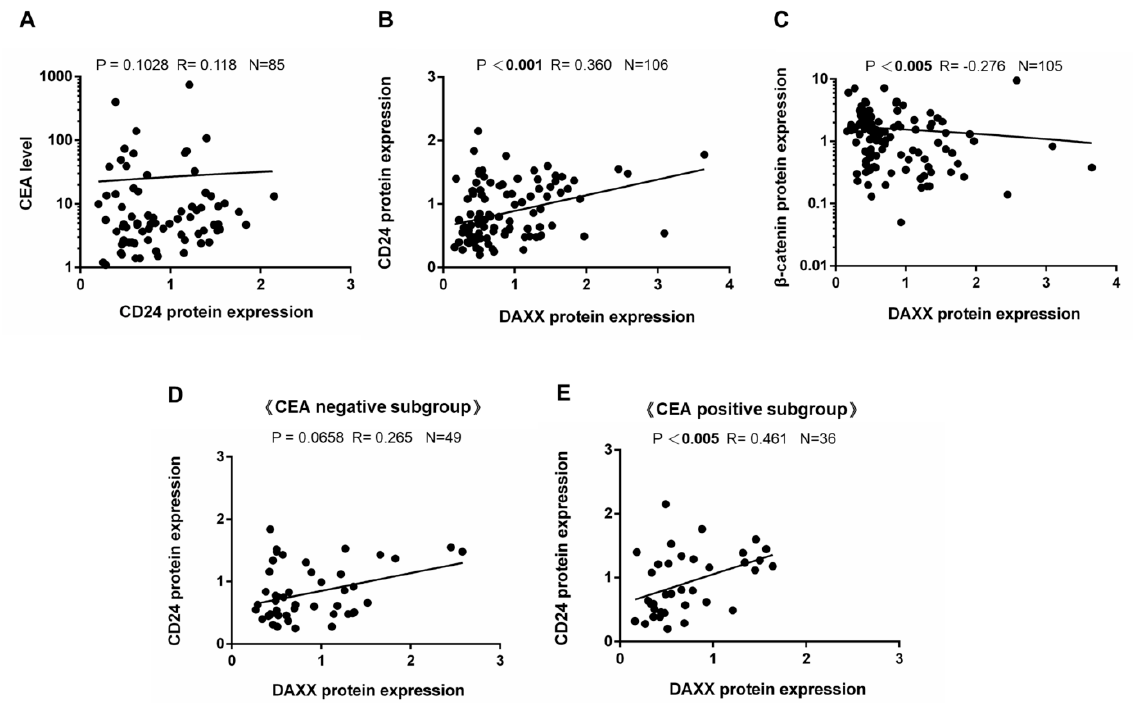
Figure 1. DAXX expression decreased in colorectal tumor and was correlated with CD24 expression. These protein levels were evaluated by WB in 106 matched pairs of colorectal cancer (CRC) and nontumoral- surrounding tissues. Spearman correlation analysis revealed that the correlation between ( A ) CD24 expression and CEA level was nonsignificant (rho = 0.118, p = 0.1028), ( B ) DAXX expression and CD24 expression was significant (rho = 0.360, p < 0.001), ( C ) DAXX expression and β -catenin expression was significant (rho = − 0.276, p < 0.005), ( D ) DAXX expression and CD24 expression was significant (rho = 0.265, p = 0.0658) in the CEA screening-negative subgroup, and ( E ) DAXX expression and CD24 expression was significant (rho = 0.461, p < 0.005) when evaluated in the CEA screening-positive subgroup. β -actin was the internal control.